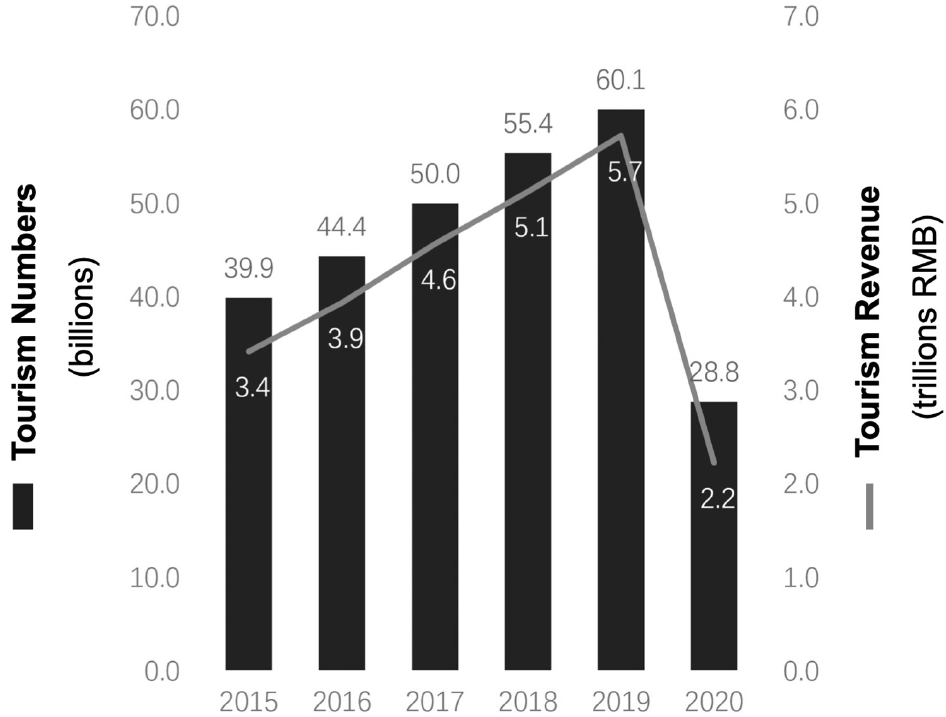
Figure 5. Tourism numbers and total tourism revenue in China from 2015 to